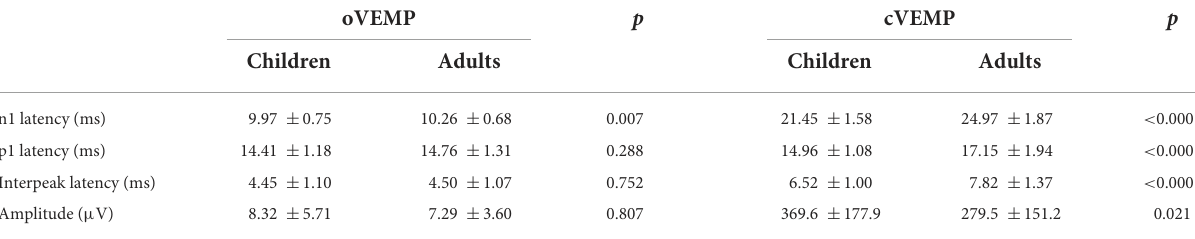
TABLE 5 oVEMP and cVEMP under 131 dB SPL stimulation in children vs.